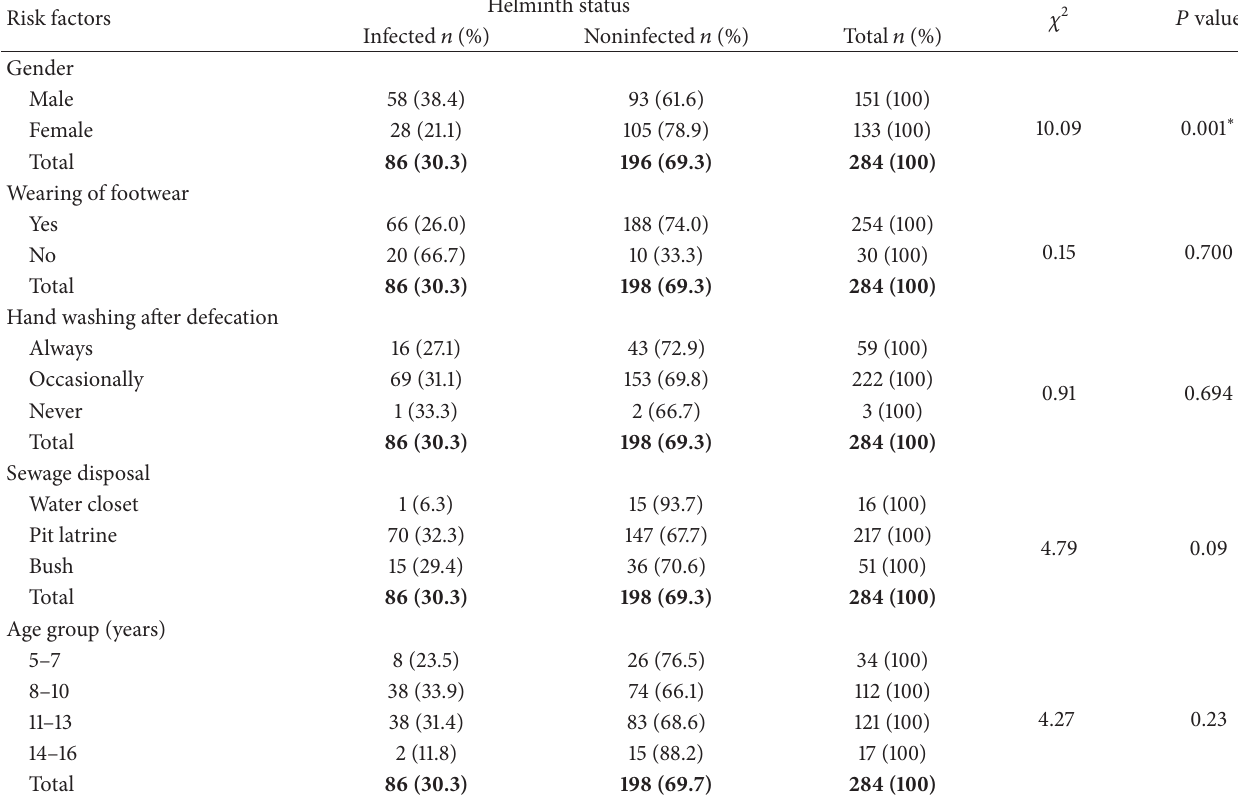
Table 2: Risk factors and prevalence of soil-transmitted helminthiasis among the study subjects.